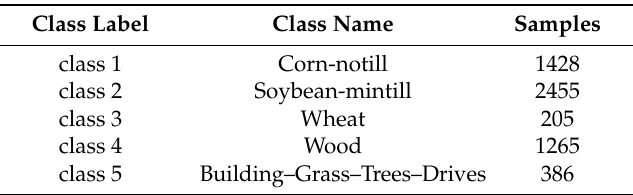
Table 1. Ground truth classes for AVIRIS Indian Pines image used in the study and their respective number of